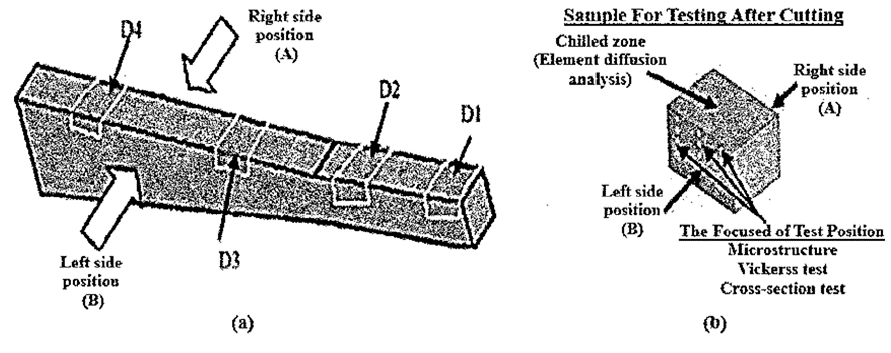
Figure 3: Microstructure and microhardness Vickers testing zone for every specimen Y-Block (a) location for focus analysis point (b) total of analysis point for each site zone (right site zone and left site zone) and for all sample testing after